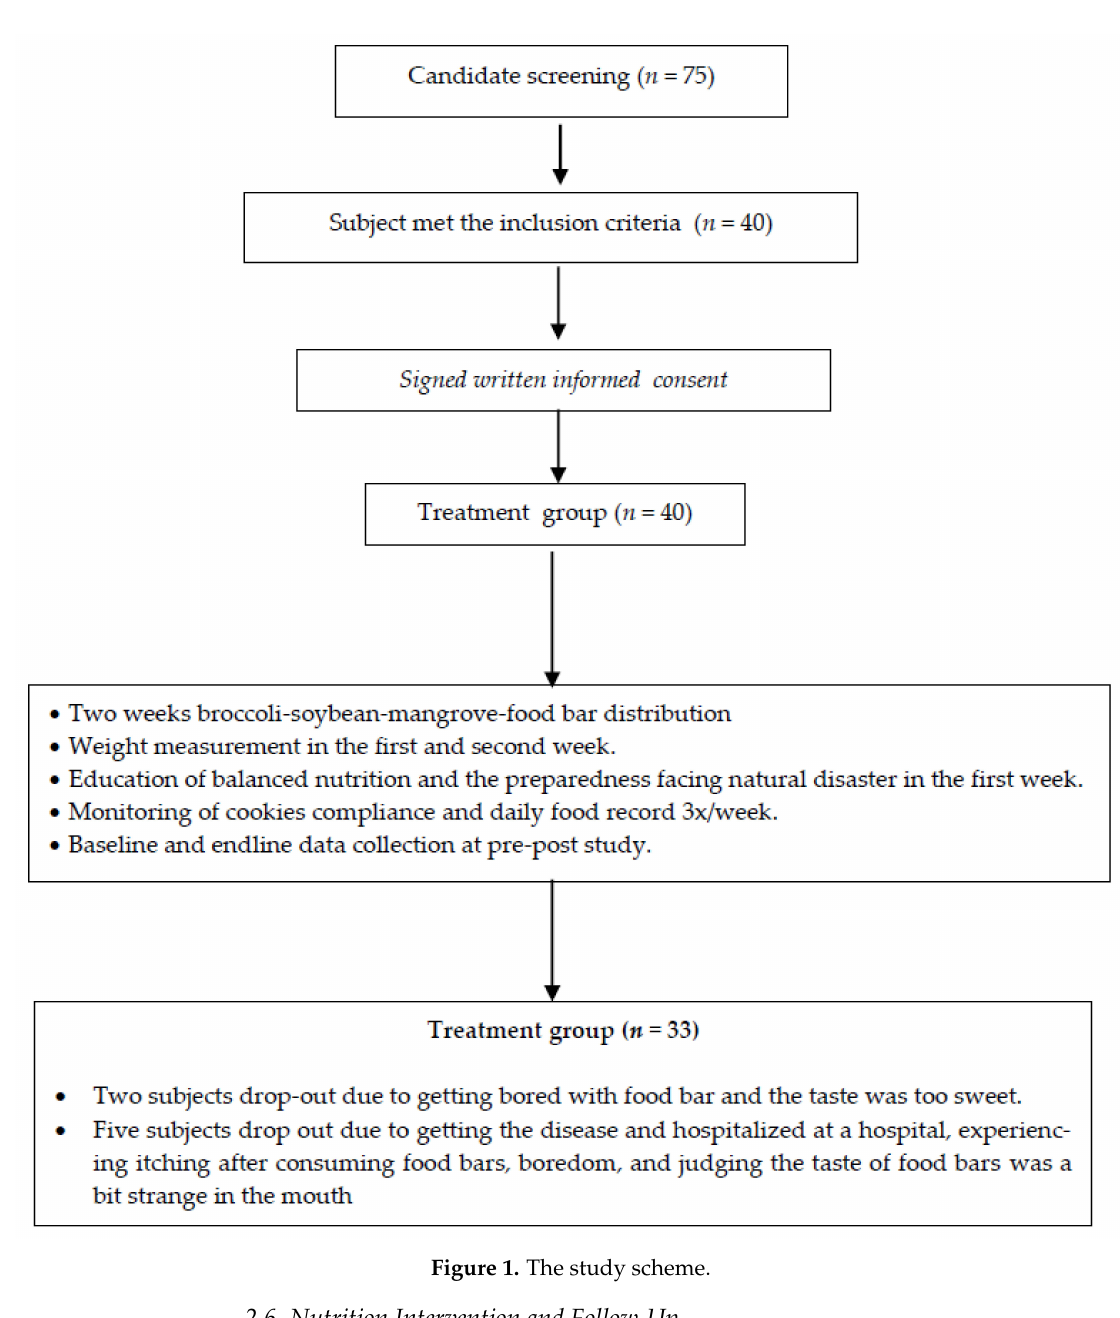
Figure 1. The study